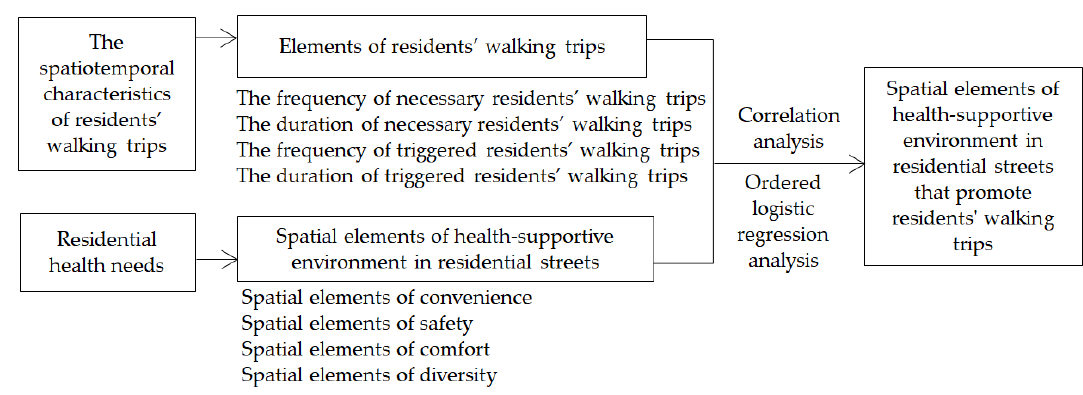
Figure 3. Study characteristics. Figure 3. Study